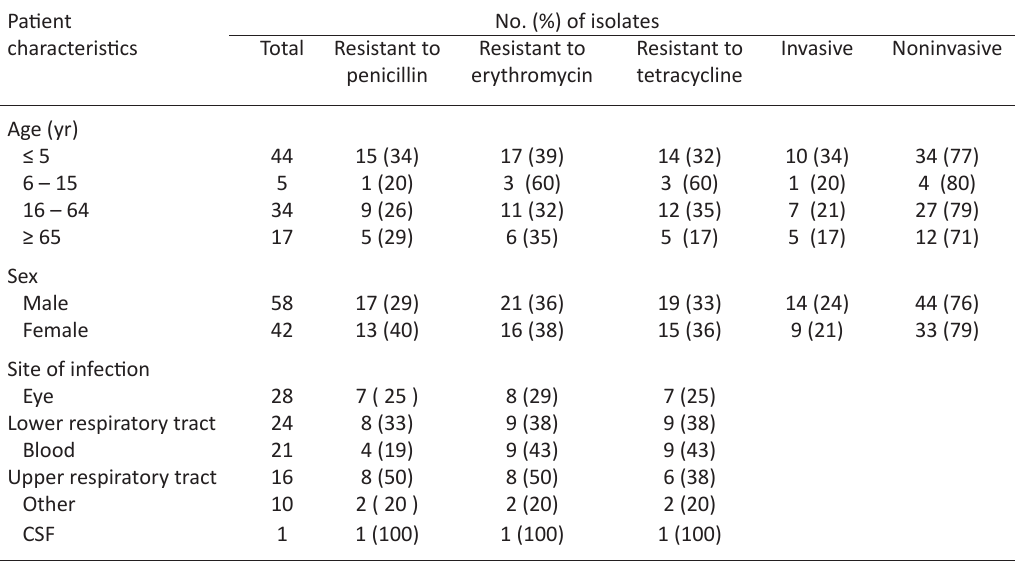
Table 3. Antimicrobial resistance of S. pneumonia isolates by age, sex, and site of infection Patient No. (%) of isolates characteristics Total Resistant to Resistant to Resistant to